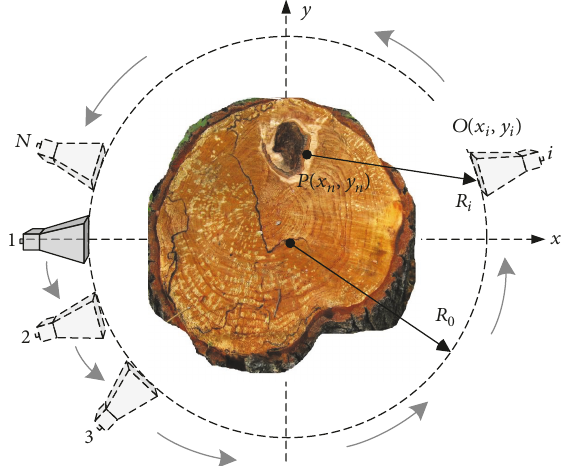
Figure 1: The geometry of TIIR